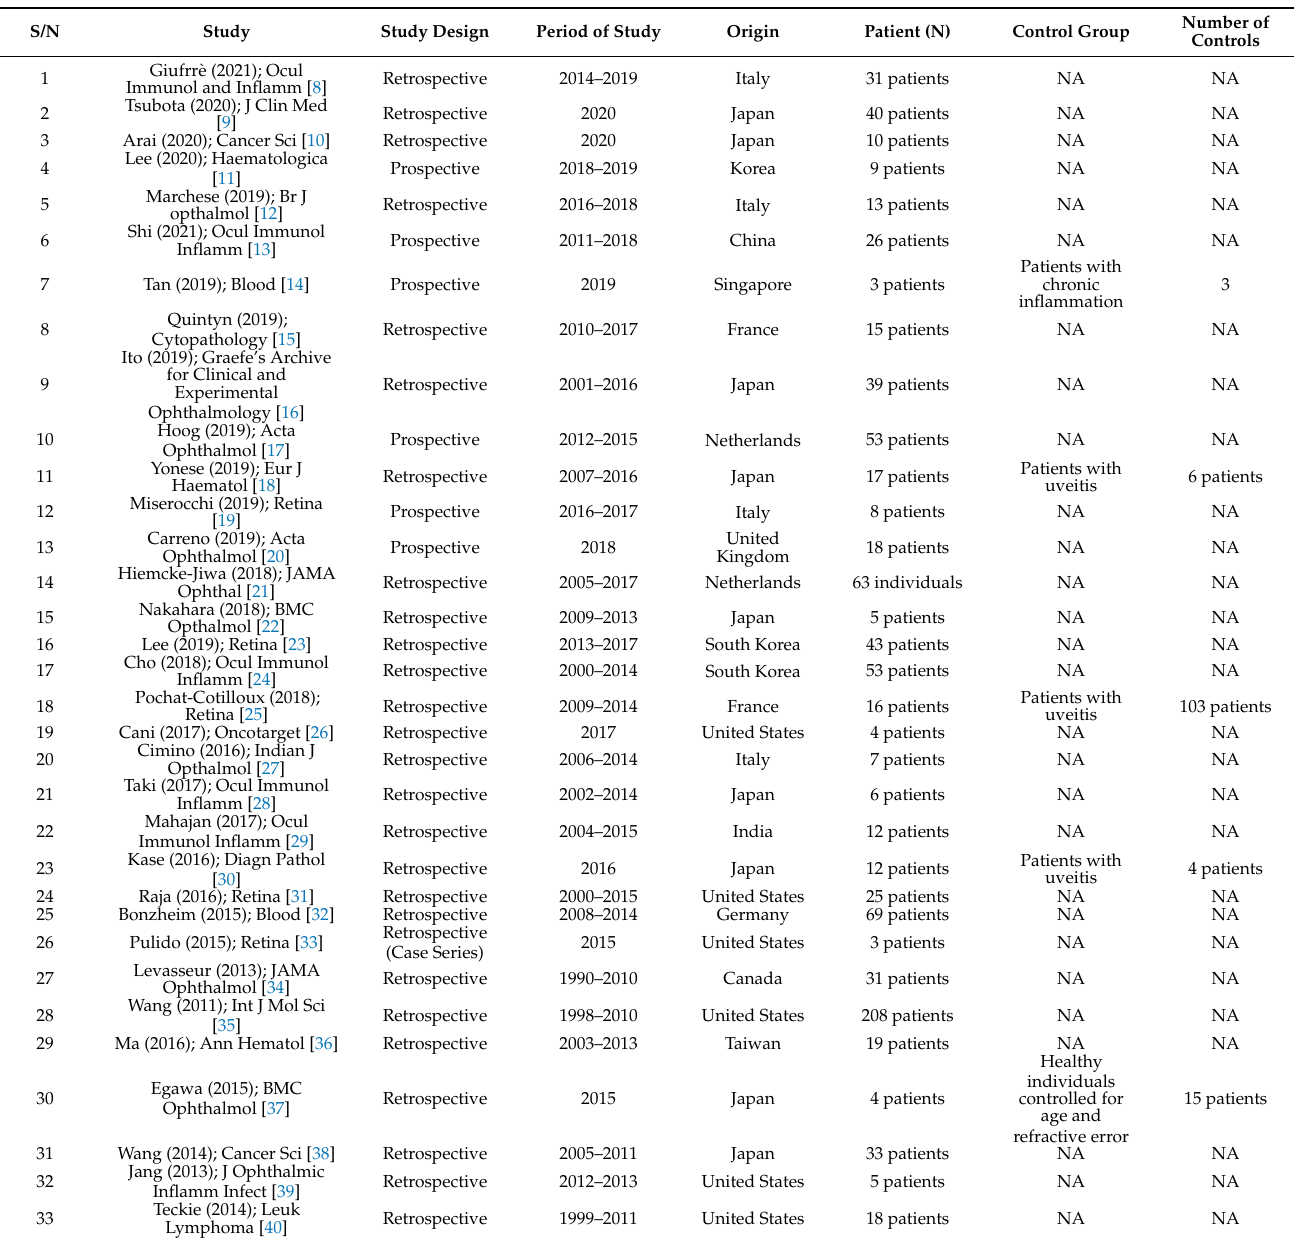
Table 1. Key design features of the studies